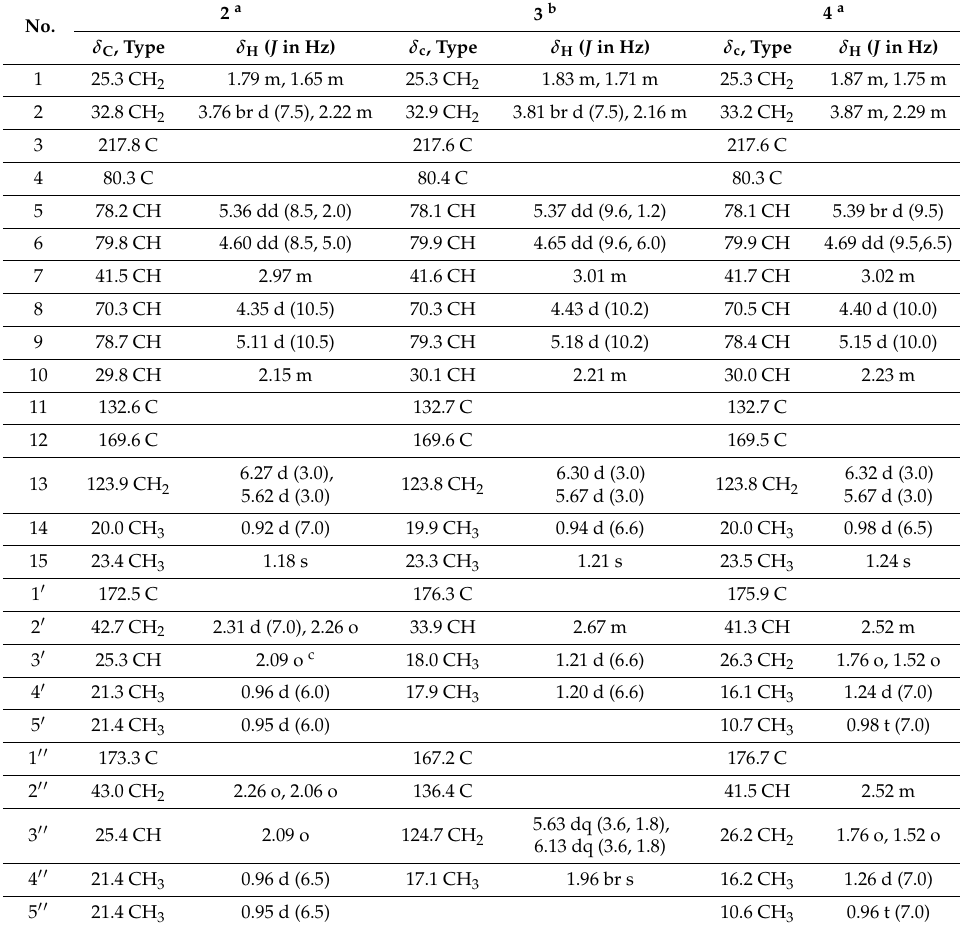
Table 1. NMR spectral data of 2 – 4 .